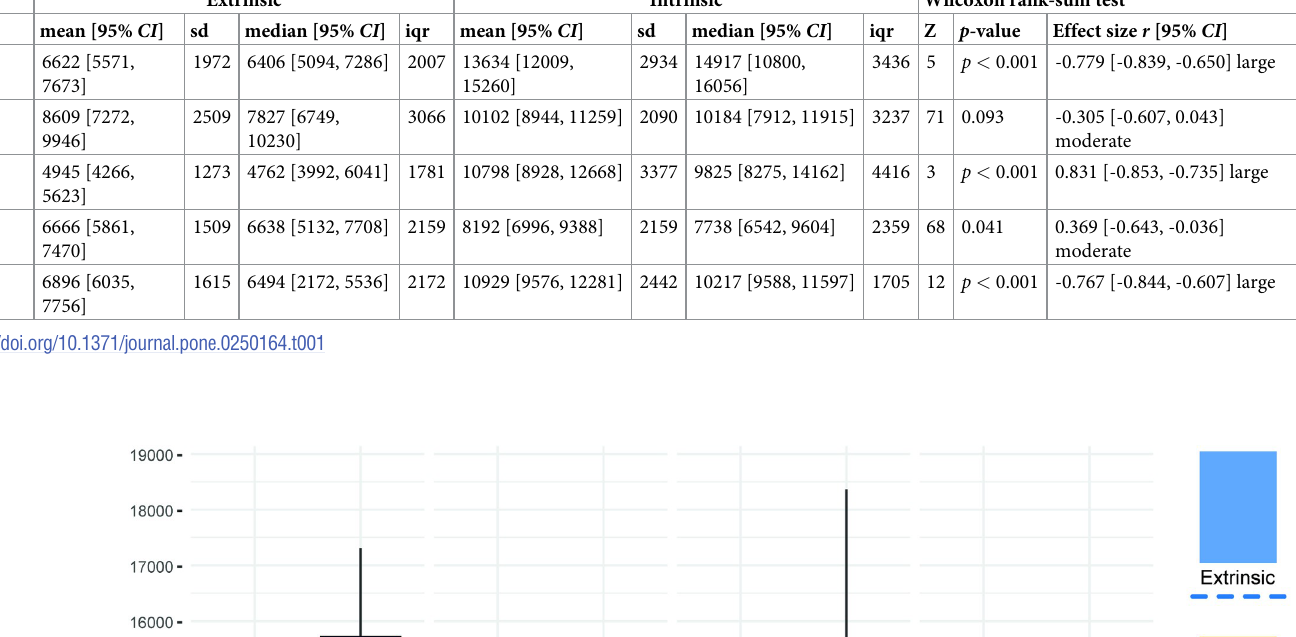
PLOS ONE | https://doi.org/10.1371/journal.pone.0250164 April 21,